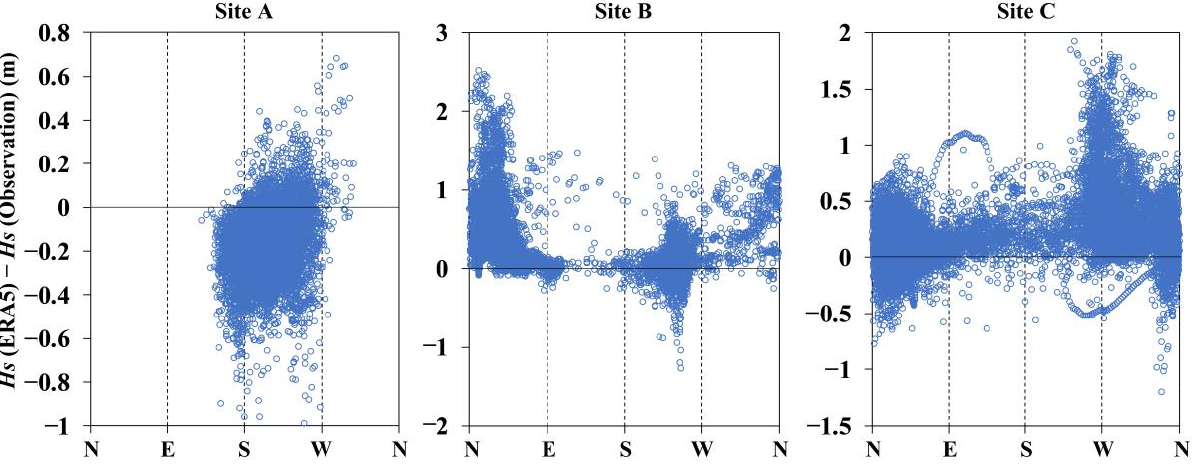
Figure 6. The error of ERA5 significant wave height compared with in situ observations in functions of wave direction for the three sites. The left, middle, and right panels display the results of Sites A, B, and C,